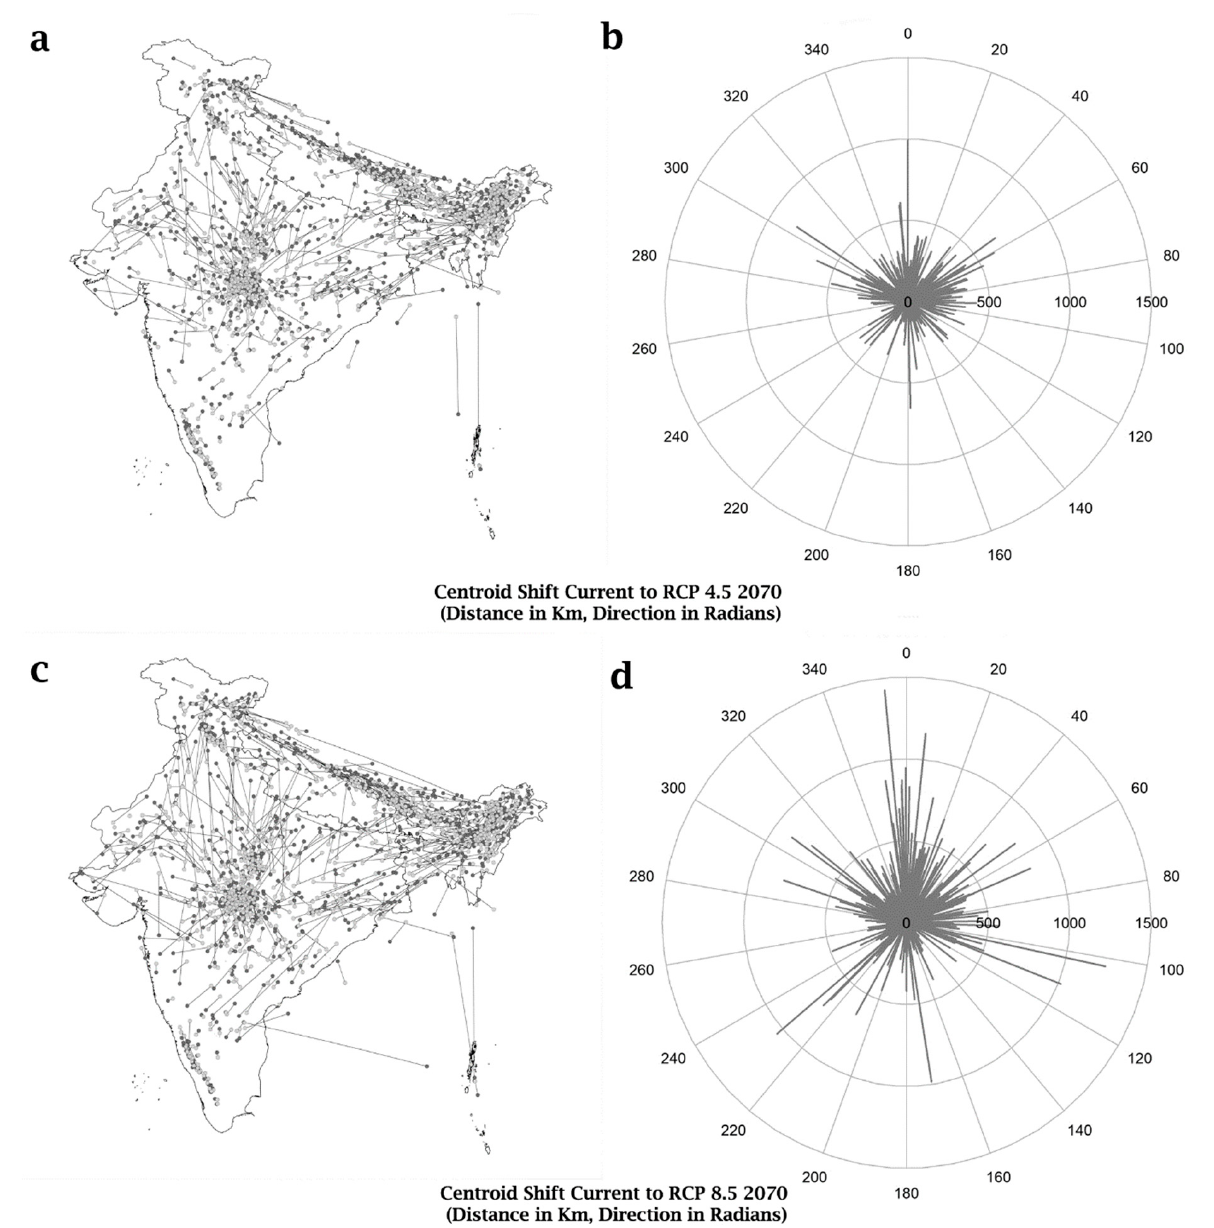
Figure 1. Range centroid shifts of bird species in 2070 under RCP 4.5 and RCP 8.5. ( a , c ) depict changes in centroid and directions as a map in the respective RCP 4.5 and RCP 8.5 scenarios for 2070. ( b , d ) depict distance (in Km) and direction (in radians) changes as a polar graph in the respective RCP 4.5 and RCP 8.5 scenarios.